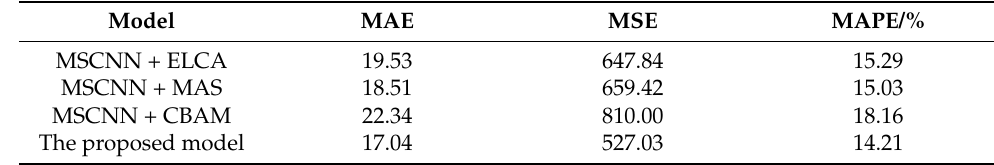
Table 4. Experimental results of adding white Gaussian noise to vibration signals.